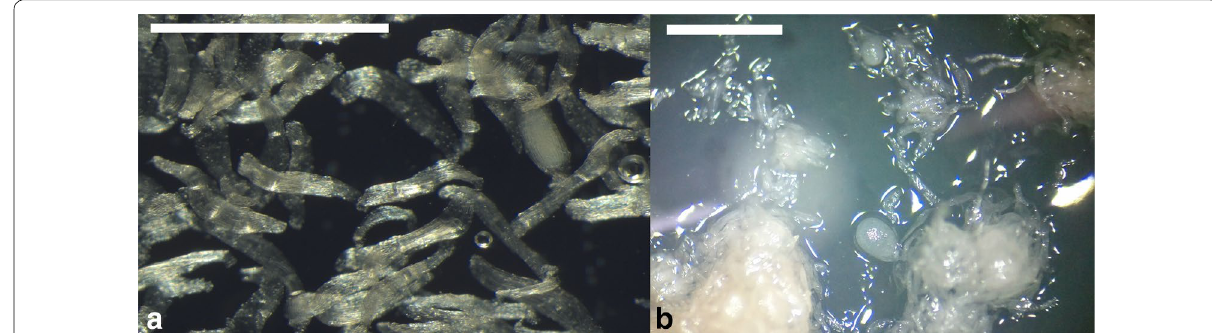
Fig. 6 Light microscope images of a in vitro collected seed ( scale bar 500 µm) in germination medium; b germinated protocorms ( scale bar 1 mm) of Aerangis ellisii , 2 months after sowing